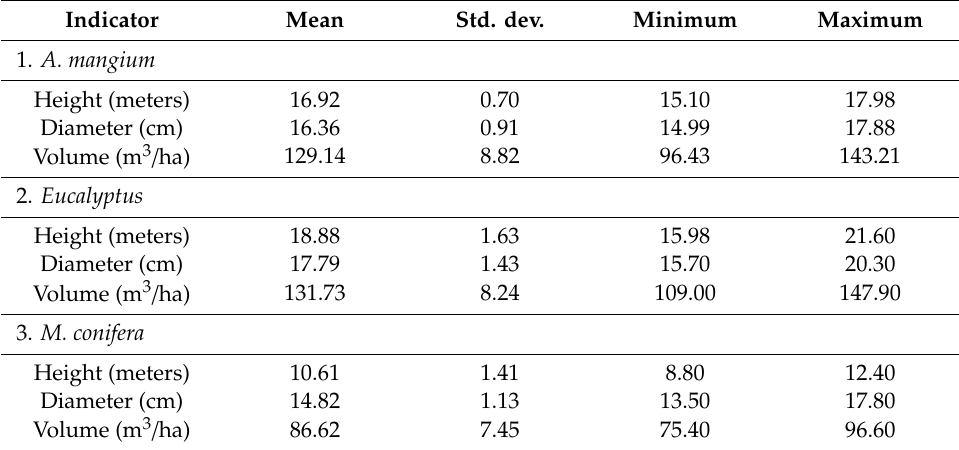
Table 2. Height, diameter, and volume of forest plantation plots in their seventh year since being established at the study